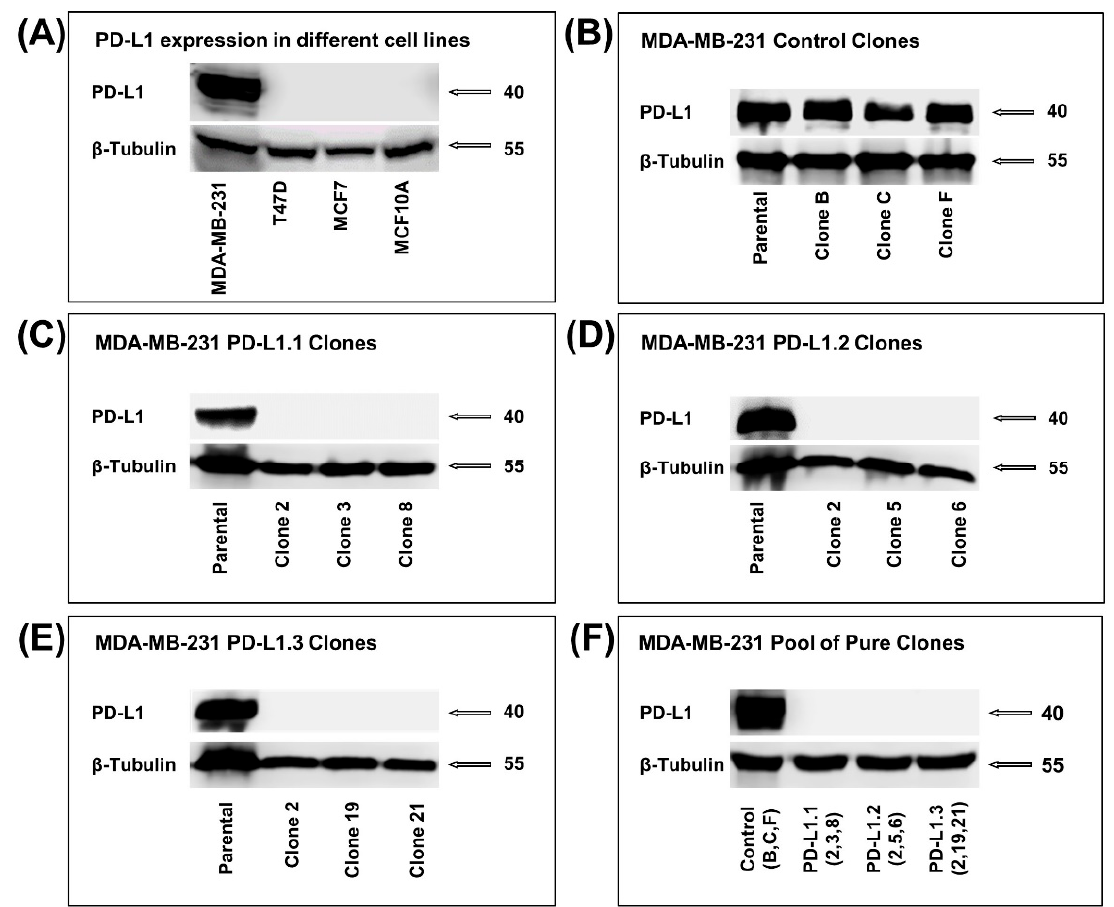
Figure 1. PD-L1 knockout in MDA-MB-231 cell line using CRISPR/Cas9. ( A ) Western blot showing the level of PD-L1 in different breast cell lines. ( B – E ) Western blot showing the level of PD-L1 in the pure clones of the control, PD-L1.1, PD-L1.2, and PD-L1.3. ( F ) Western blot showing PD-L1 level in the pool of the three selected pure clones from the control and each design of sgRNA targeting PD-L1.